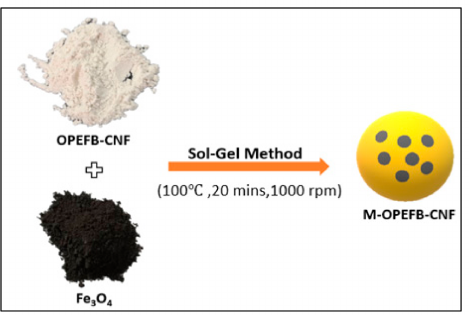
Figure 2. Fabrication of the M-OPEFB-CNF composite by sol-gel